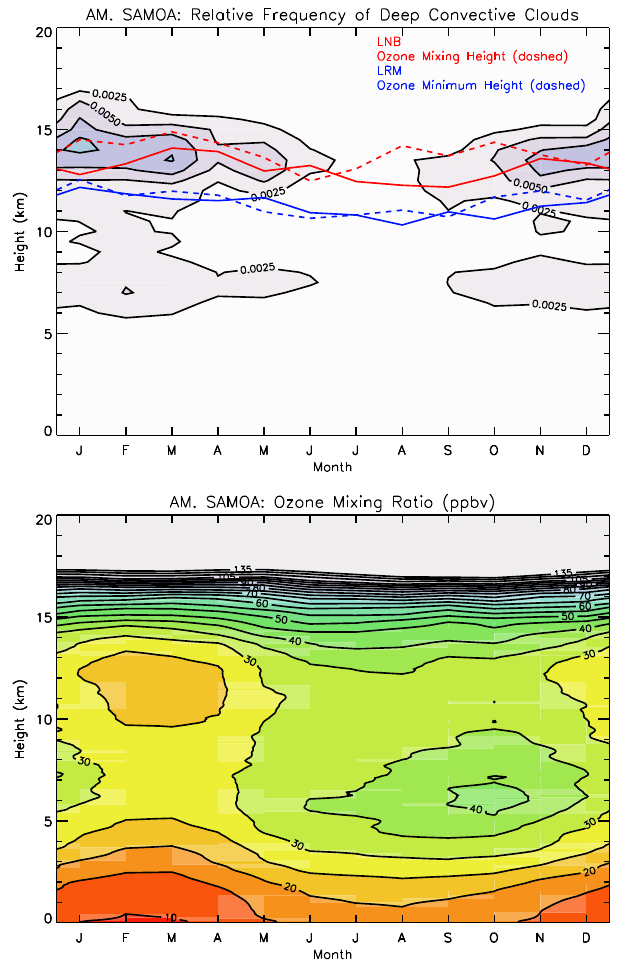
Fig. 9. (Top) annual cycle of the relative frequency distribution Fig. 9. (top) annual cycle of the relative frequency distribution of deep convective cloud top heights of deep convective cloud top heights within 1000km of American within 1000 km of American Samoa (contours). Also included is the annual cycle of the LNB (red, Samoa (contours). Also included is the annual cycle of the LNB (red, solid), the ozone mixing height (red, dashed), the LRM height solid), the ozone mixing height (red, dashed), the LRM height (blue, solid), and the ozone minimum (blue, solid), and the ozone minimum height (blue, dashed). (Bot- height (blue, dashed). (bottom) annual cycle of the ozone concentration (ppbv) at American Samoa, tom) annual cycle of the ozone concentration (ppbv) at American similar to Fig. 3d in Thompson et al. (2011). Orange and red colors indicate relatively low values, blue 34 Samoa, similar to Fig. 3d in Thompson et al. (2011). Orange and colors indicate relatively high values. red colors indicate relatively low values, blue colors indicate rela- tively high